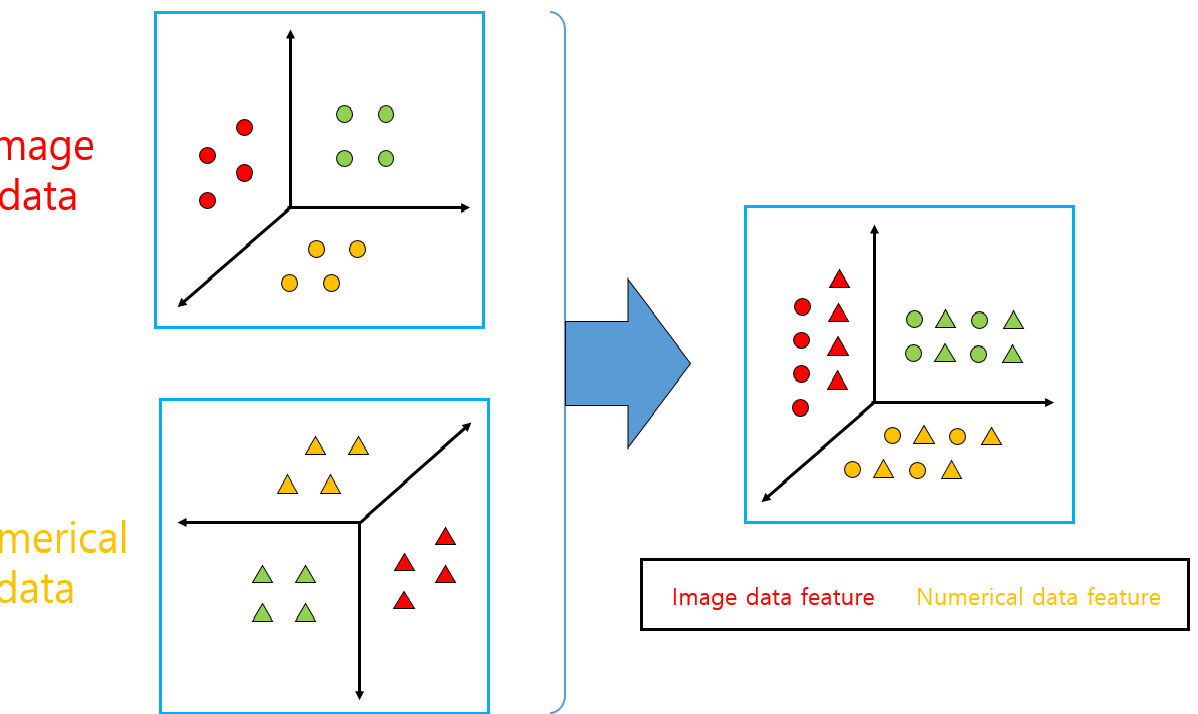
Figure 7. Integration between learned representations: It is a method of combining representations learned with different neural networks (CNN, LSTM). The representations learned through each neural network are connected to and combined with the hidden layer, and learning is performed in a way that finds the optimal weight connected to the hidden layer.